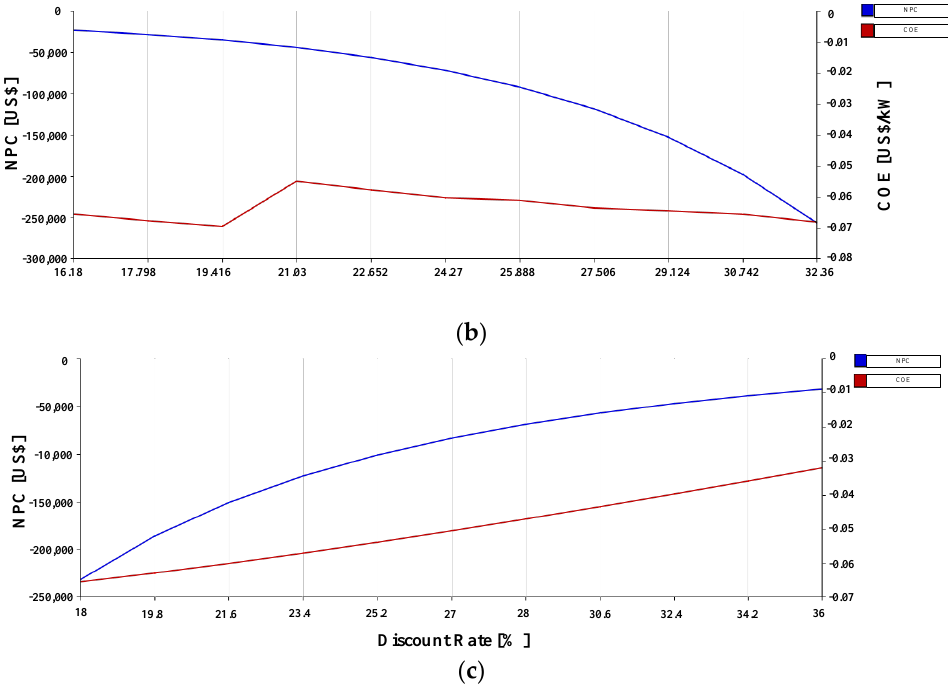
Figure 17. The results of sensitivity analysis regarding ( a ) optimal system type; ( b ) effect of different values of inflation rate on NPC and COE of the MG; ( c ) effect of different values of discount rate on